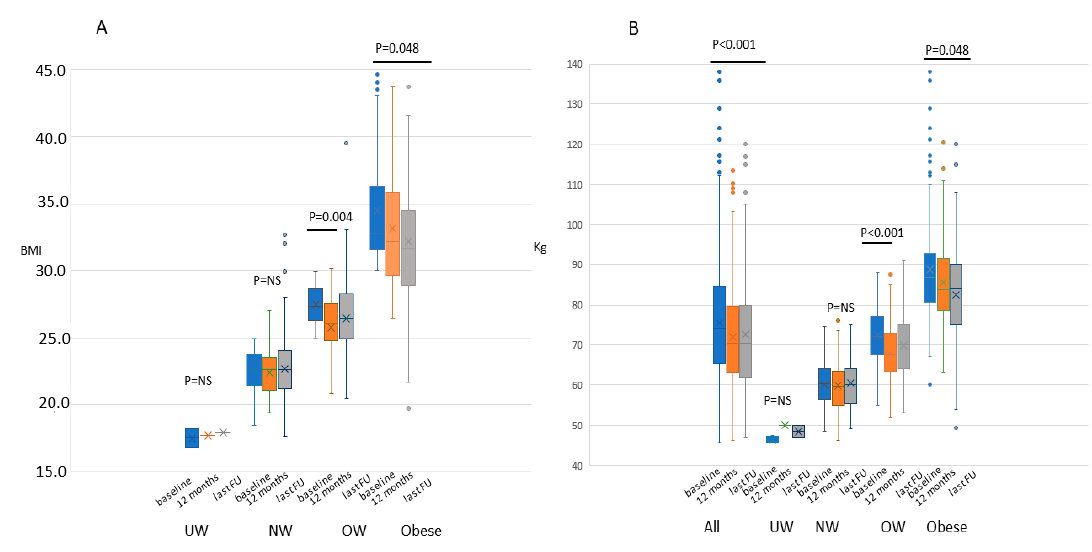
Figure 1. Figure 1 represents the BMI ( A ) and Kg ( B ) changes for patients categories’ throughout the study. ( A ) represents the body mass index (BMI) evaluation at the baseline (blue), at 12 months (orange) and at the end of the study (grey) in the underweight (UW), normal-weight (NW), overweight (OW) and obese patients by the whisker plot. The dots represent the outlier values. The estimated di ff erence between BMI, weight, and physical activity along time-points was performed by means of ANOVA with repeated measures. No statistically significant di ff erences ( p = NS) were seen in the UW and NW groups along the time, whereas a statistically significant di ff erence was shown in OW patients after one year from the baseline ( p = 0.004, mean di ff erence − 0.72, 95%CI = − 1.20 − 0.23), but not at the end of the study ( p = 0.065, mean di ff erence − 0.45,95%CI = − 1.1 − 0.54), and in obese patients ( p = 0.048, mean di ff erence − 0.92, 95%CI = − 1.82 − 0.01) at the end of the study, with a slow but progressive decrease of BMI. ( B ) represents weight evaluation at the baseline (blue), at 12 months (orange) and at the end of the study (gray) in the total population (all), underweight (UW), normal-weight (NW), overweight (OW) and obese patients by the whisker plot. The dots represent the outlier values. Globally the median weight decreased from 74.1 to 70.4 kg at the end of the study ( p < 0.001 mean di ff erence − 3.39, 95%CI = − 4.41 − 2.36), obese women moved from 86.8 to 84 kg ( − 3.2%, p = 0.04 8, mean di ff erence − 1.51, 95%CI = − 1.80 − 0.01), overweight women moved from 72.2 kg, at the entry to 67.6 after one year ( − 6.3% p < 0.001 mean di ff erence − 1.90, 95%CI = − 3.10 − 0.70). No di ff erences throughout the study